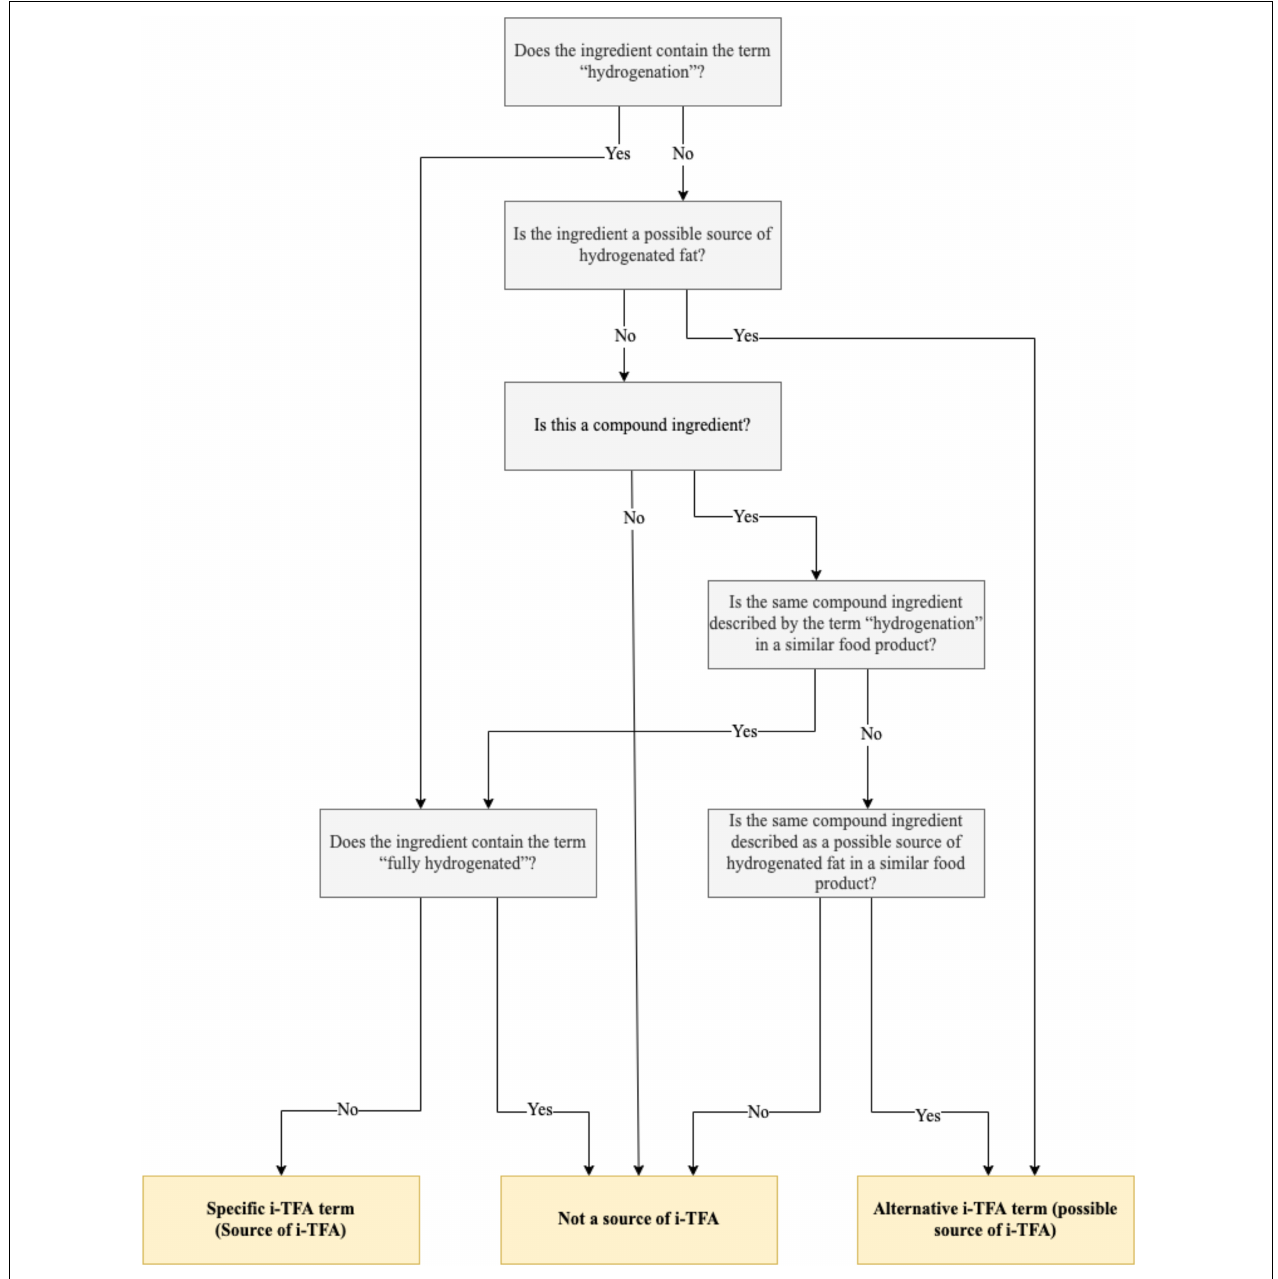
FIGURE 2 | Decision criteria for determining whether a packaged food ingredient is a source of industrially produced trans-fat acids (i-TFA), a possible source of i-TFA, or not a source of